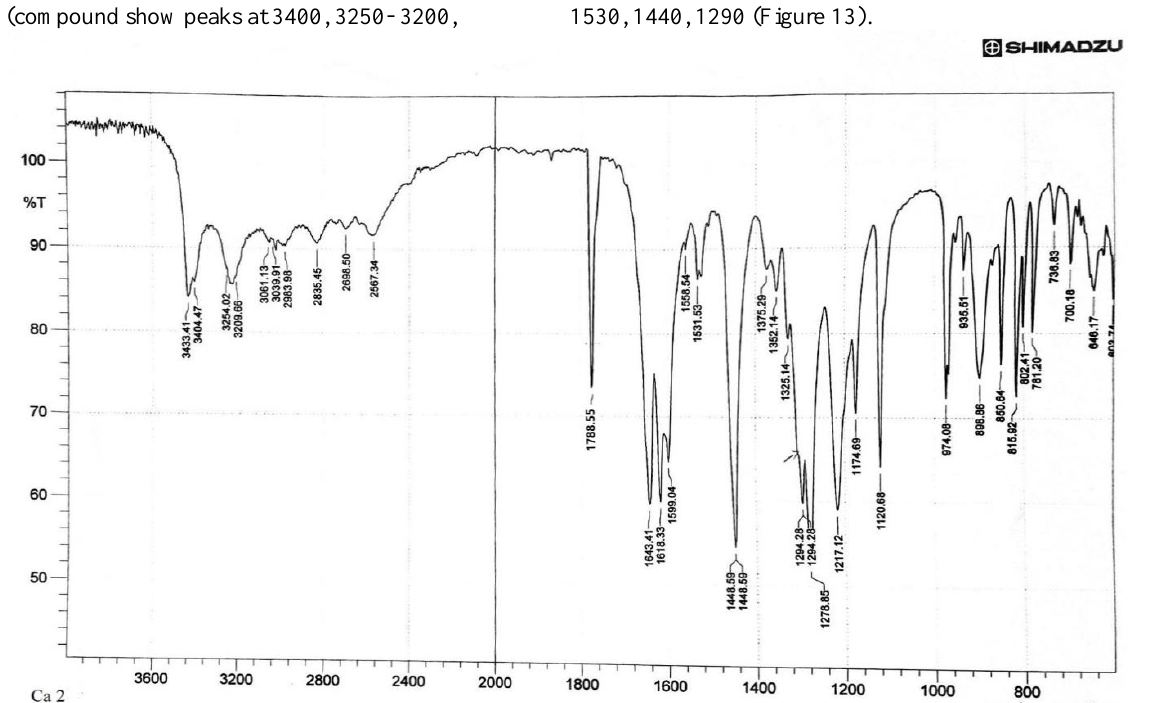
3000, 2900, 2800, 2500, 1640, 1620, 1600, 1530, 1440, 1290 (Figure 13).